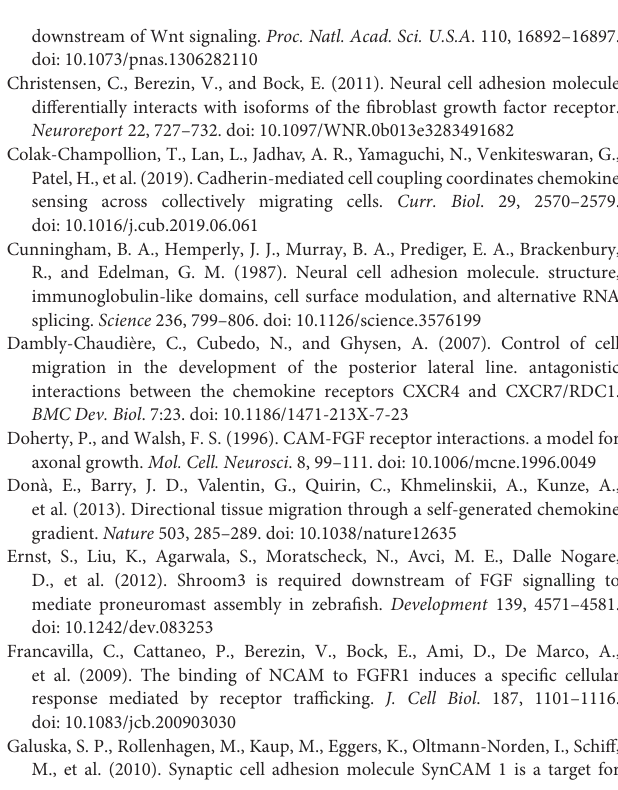
Supplementary Figure S9 | The knockdown of ncam1b results in severe abnormalities in primordium shape and migration. Lateral views of Tg(ClaudinB::lynGFP) primordia at 48 hpf. (A) Primordia of uninjected siblings have an elongated shape and a constant size, they migrate on a direct path to the tip of the tail. (B–D) Primordia of ncam1b -morphants are reduced in size and lack directional migration. They either stop migration prematurely or they leave the horizontal myoseptum, perform a u-turn and migrate backwards. (E) Double- knockdown of ncam1a and ncam1b phenocopies the single- knockdown Supplementary Video 1 | Migration of the primordium in wild type siblings. Supplementary Video 2 | Control-morpholino injected embryos show no altered phenotype of the pLLS. Supplementary Video 3 | A knockdown of ncam1a has weaker effects on primordium migration and proneuromast formation. Supplementary Video 4 | The primordium of ncam1b -morphants just reaches the end of the yolk extension. Supplementary Video 5 | Knockdown of ncam1b leads primordia to deviate from their path along the horizontal